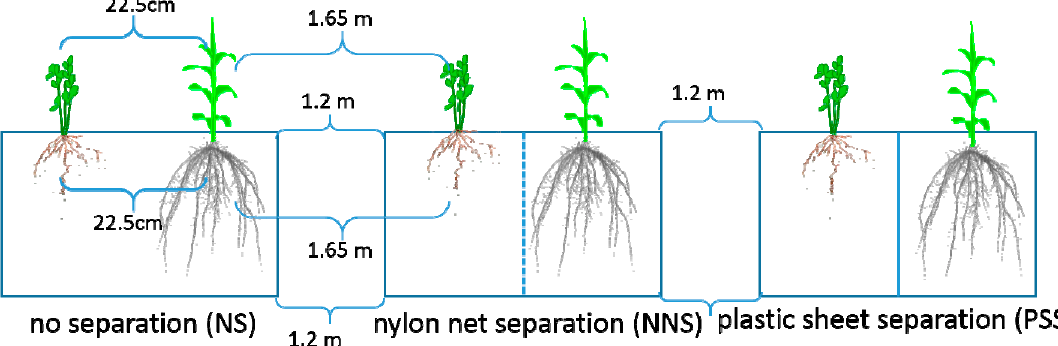
Figure A1. Schematic diagram of the maize/alfalfa intercropping pot experiment.